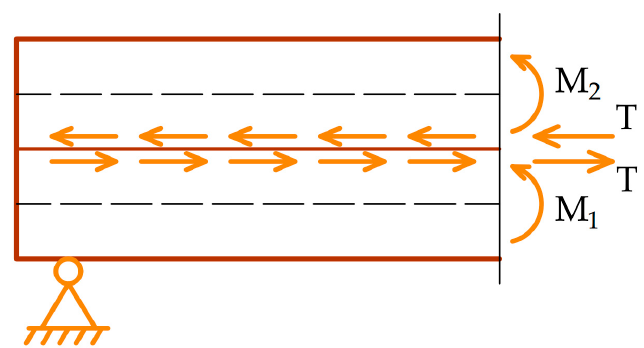
Figure 1. Behaviour of a layered concrete member, where M 1 and M 2 are the bending moments of each layer and T is the shear force acting at the interface between the layers.